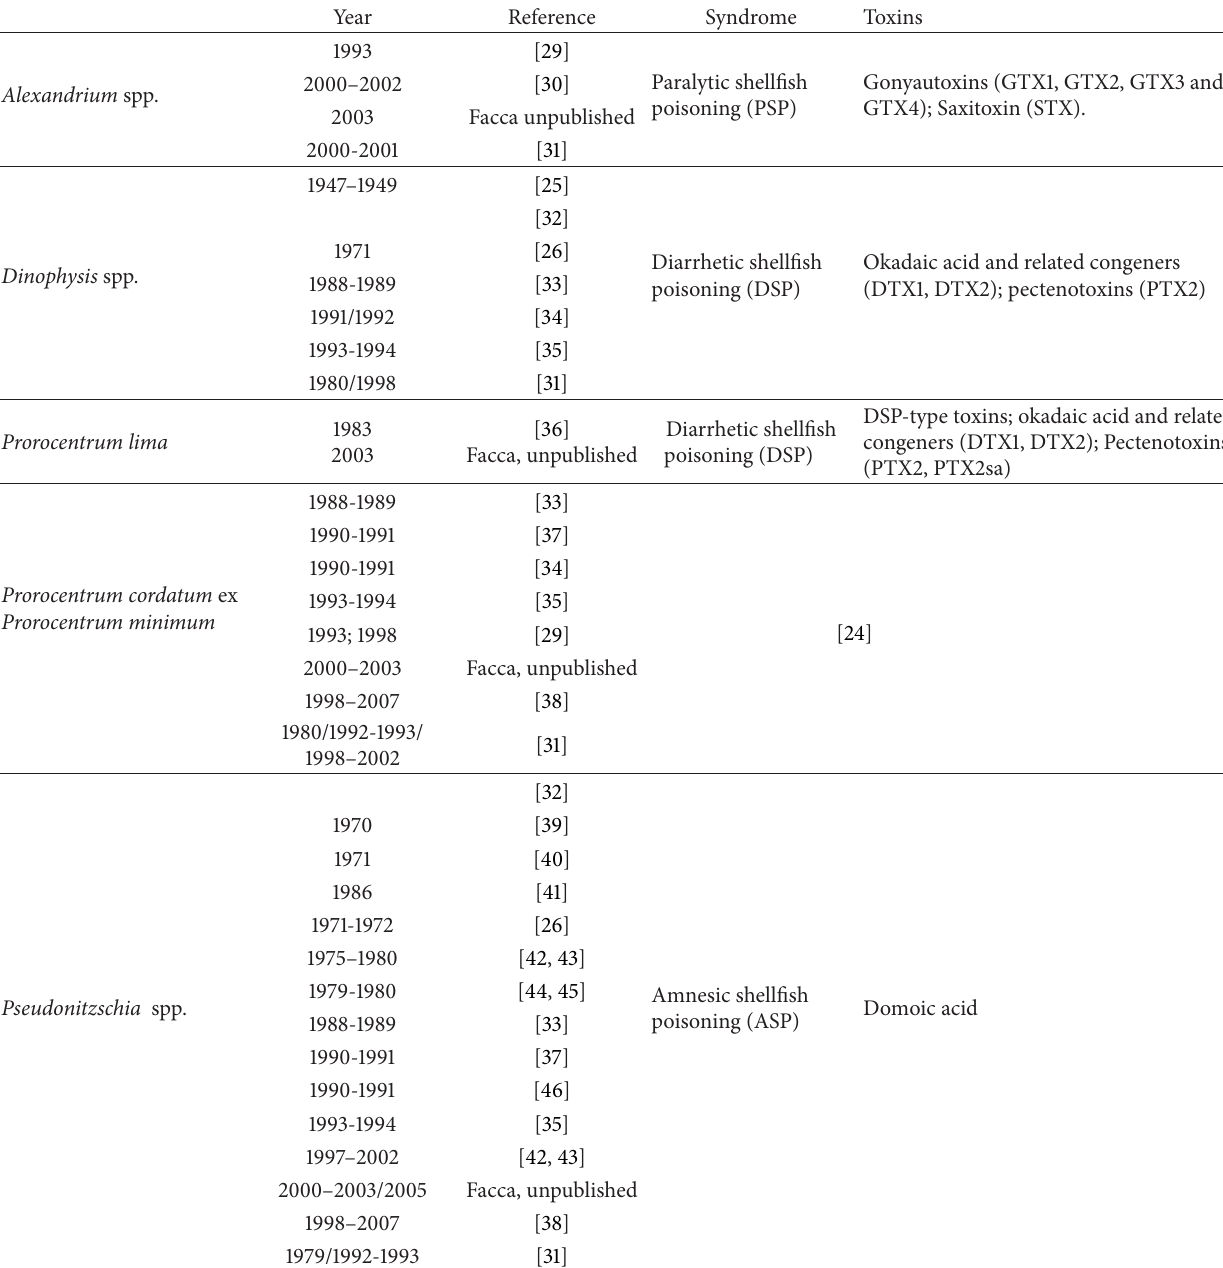
Table 1: Harmful algae records in the lagoon of